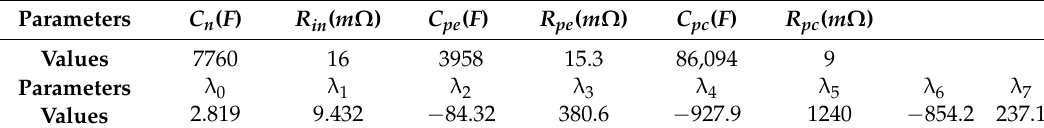
Table 1. Parameters for equivalent circuit model of a battery cell.